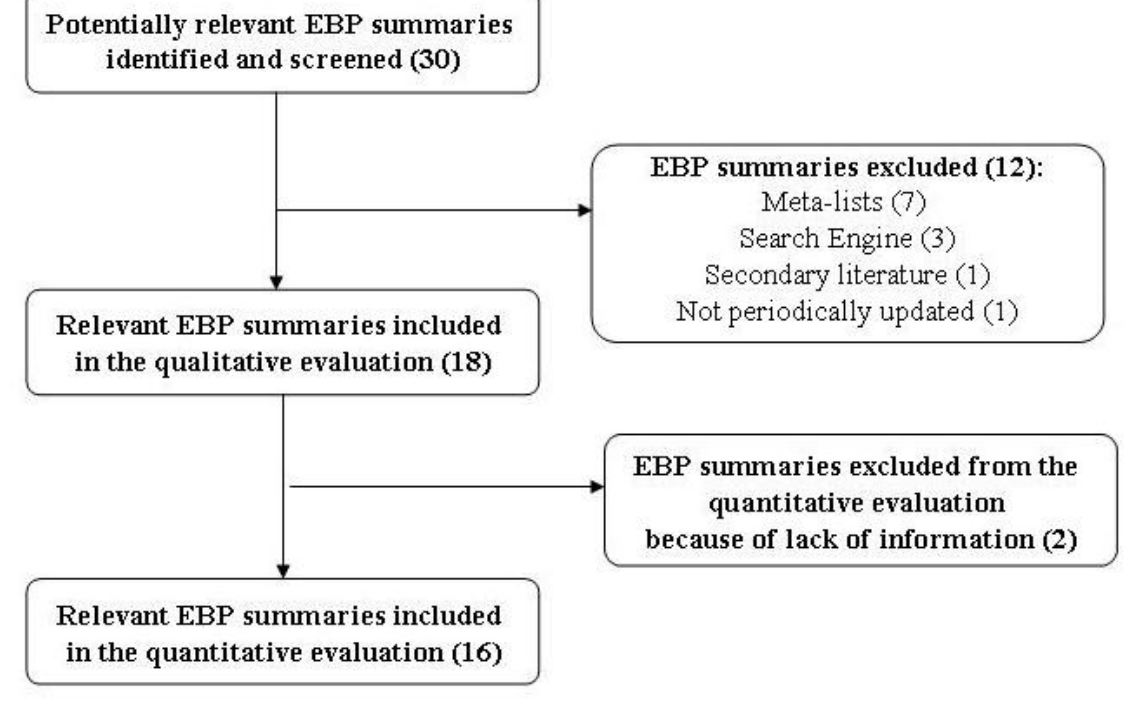
Figure 2. Flow diagram of the EBP point-of-care summary providers included in the